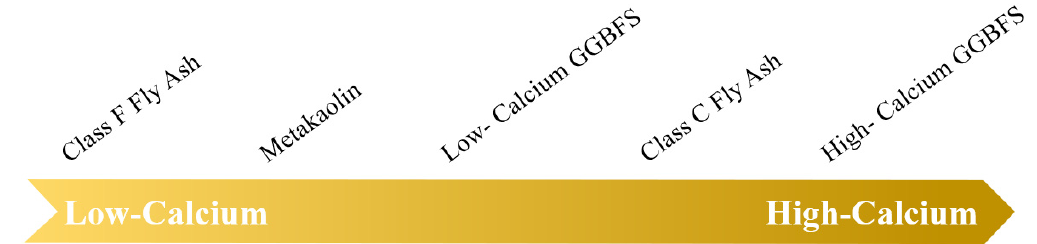
Figure 2. The Ca content level of different solid aluminosilicate precursors.